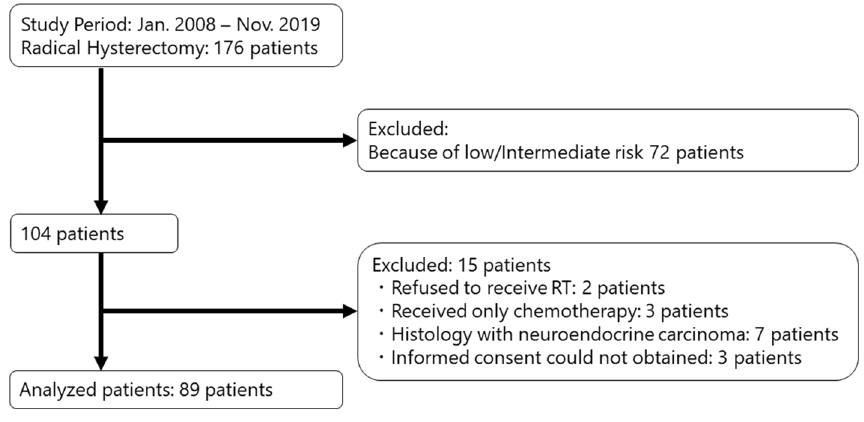
Figure 1. Patient flow diagram of this